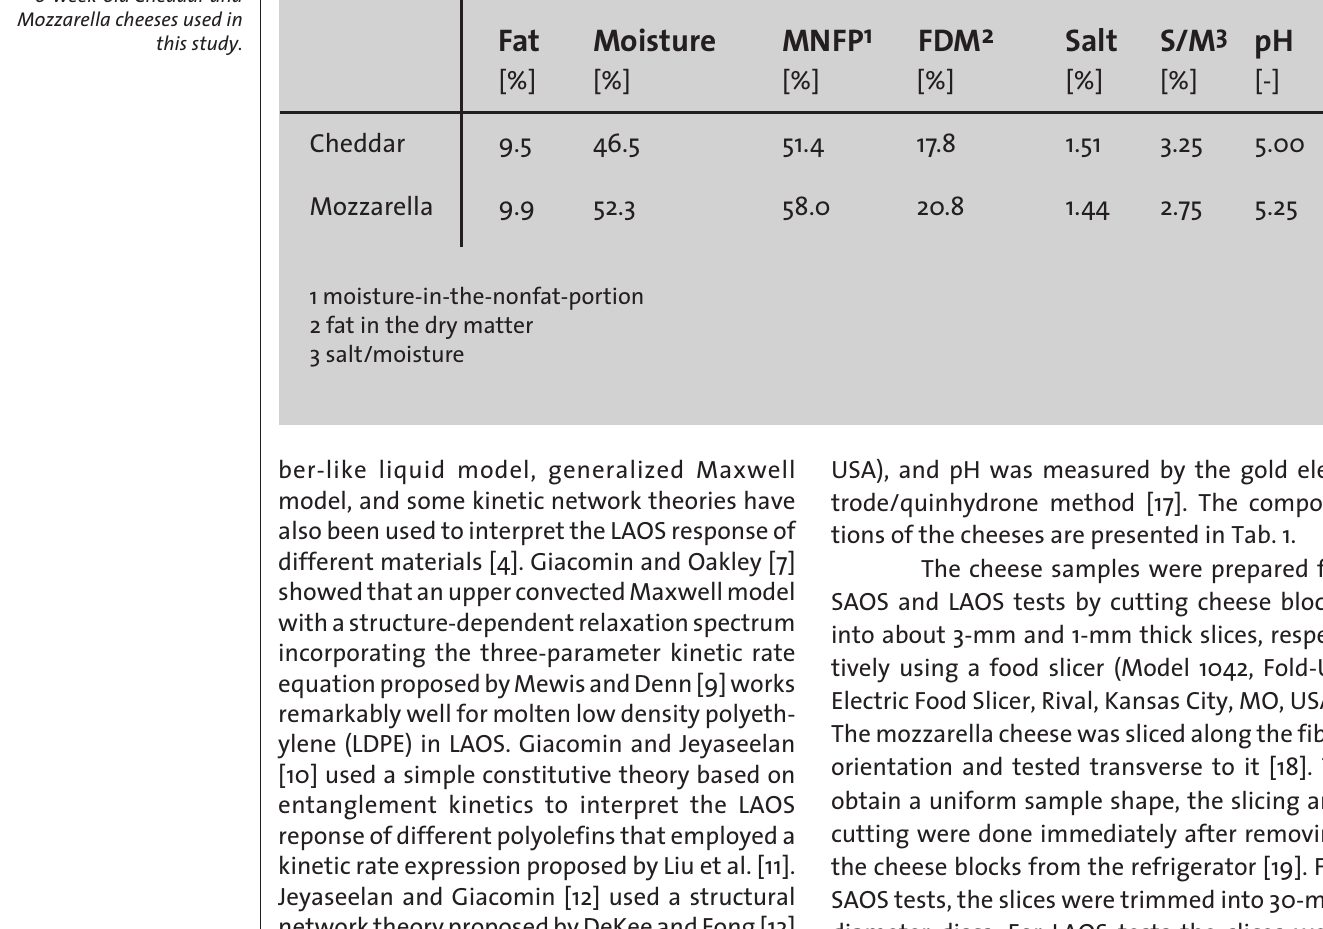
Table 1: Composition of 6-week-old Cheddar and Mozzarella cheeses used in this